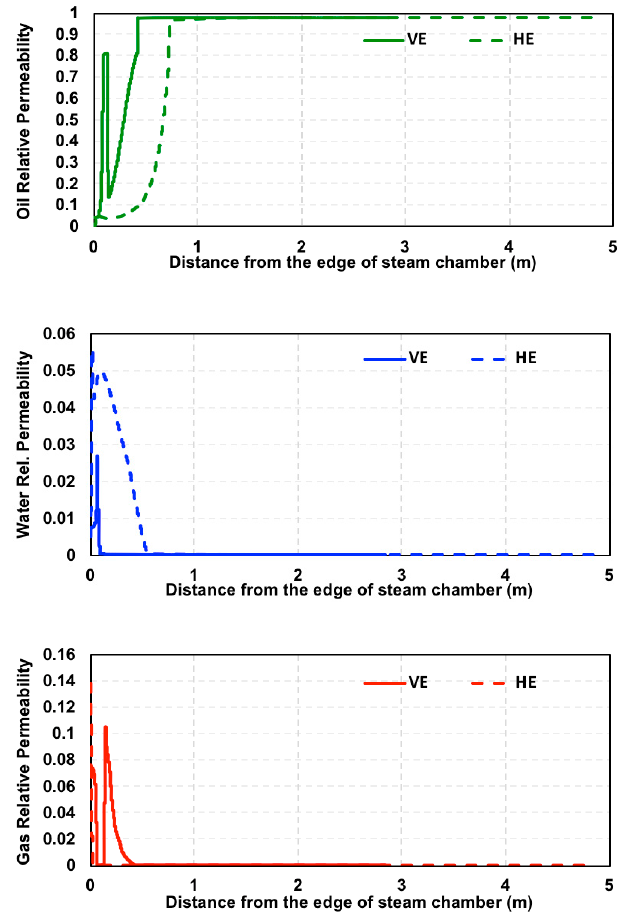
Figure 15. Oil relative permeability ( top ), water relative permeability ( center ) and gas relative permeability profiles ( bottom ) versus distance for the VE and HE models.